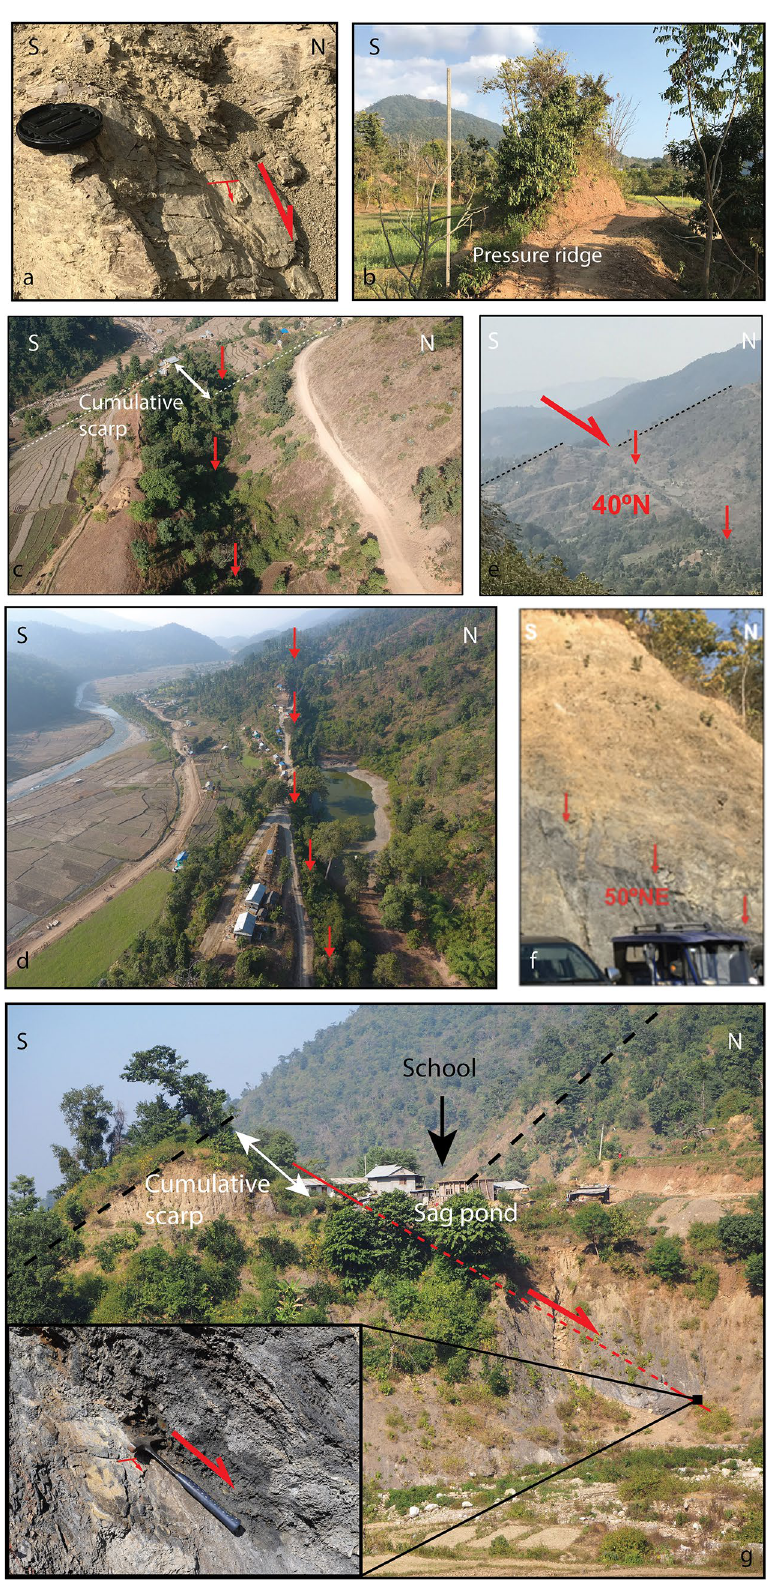
Figure 3. Field pictures along the fault located on Fig. 4a. ( a ) Normal fault centimetric slickensides, ( b ) Topographic expression of the ridge, ( c,d ) cumulative scarp and sag pond within the Bheri-Sarda corridor, ( e,f ) dip of the fault and ( g ) large outcrop across the fault. The fault affects the black slates of the lesser Himalayas. Fault plane affecting the black schists. Kinematic criteria comprise slickensides, with steps normal to the fault surfaces, perpendicular to striae. Slicken lines in the vicinity of the hammer are calcite striae indicating the direction and sense of slip which is consistent with a normal fault (Here the lacking compartment is the hangingwall which collapsed). Figure generated with Adobe illustrator CS6 (http:// www. adobe. com/ fr/ produ cts/ illus trator.